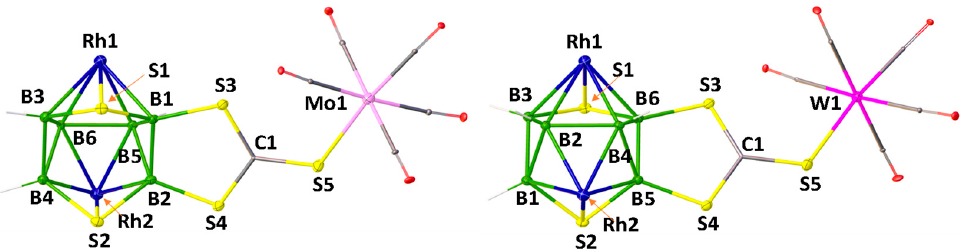
Figure 2. Molecular structures and labelling diagrams of 5 and 6 (note that Cp* ligands attached to metals are omitted for clarity.) Selected bond lengths (Å) and angles (°): 5 : B1 − B2 1.808(8), Mo1 − S5 2.5388(15), S5 − C1 1.668(6), S3 − B1 1.869(6); C1 − S5 − Mo1 117.1(2), C1 − S3 − B1 101.1(3). 6 : B5 − B6 1.809(4), W1 − S5 2.5293(7), S5 − C1 1.672(3), S3 − B6 1.873(3); C1 − S5 − W1 116.73(9), C1 − S3 − B6